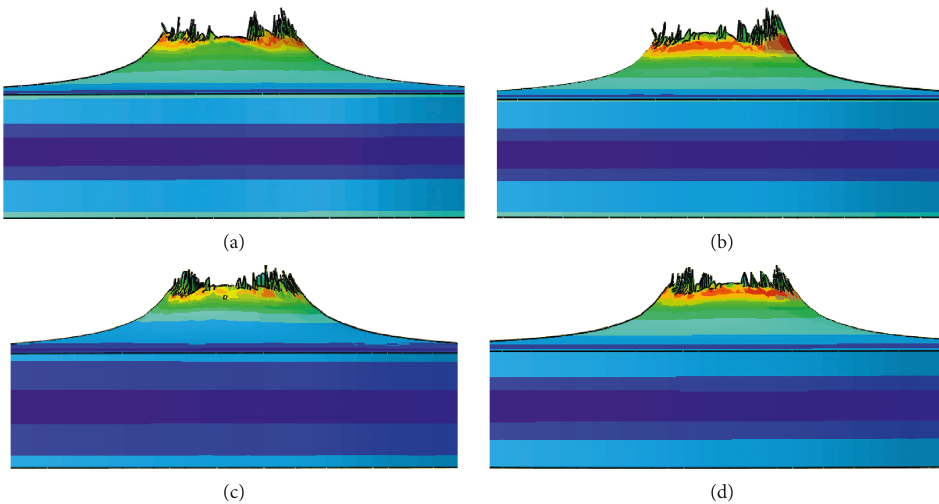
Figure 14: Macrographs of target plate under projectile impact at V